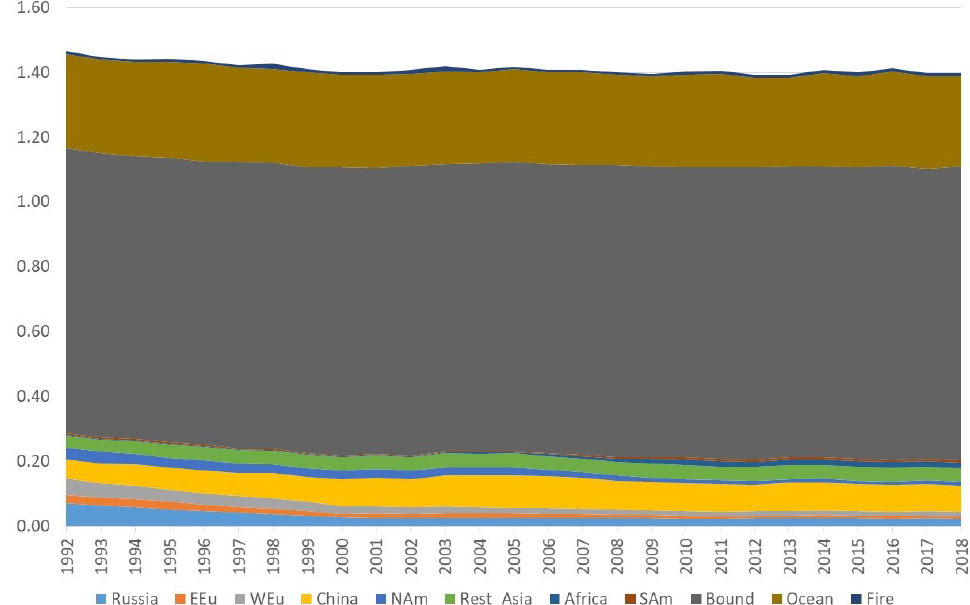
Figure 9. Model calculations with variable emissions of the source apportionment of annual average GEM at Villum. The DEHM model was used for 2 years (1990 and 1991) to spin up the model. In the model, re-emissions from the ocean and contributions from boundary conditions at the Equator are included. Source regions: Russia – Russia; EEU – eastern Europe; WEu – western Europe; China – China; Africa – Africa; SAm – South America; Bound – boundary condition; Ocean – ocean; Fire – wildfire. Unit: ngm − 3